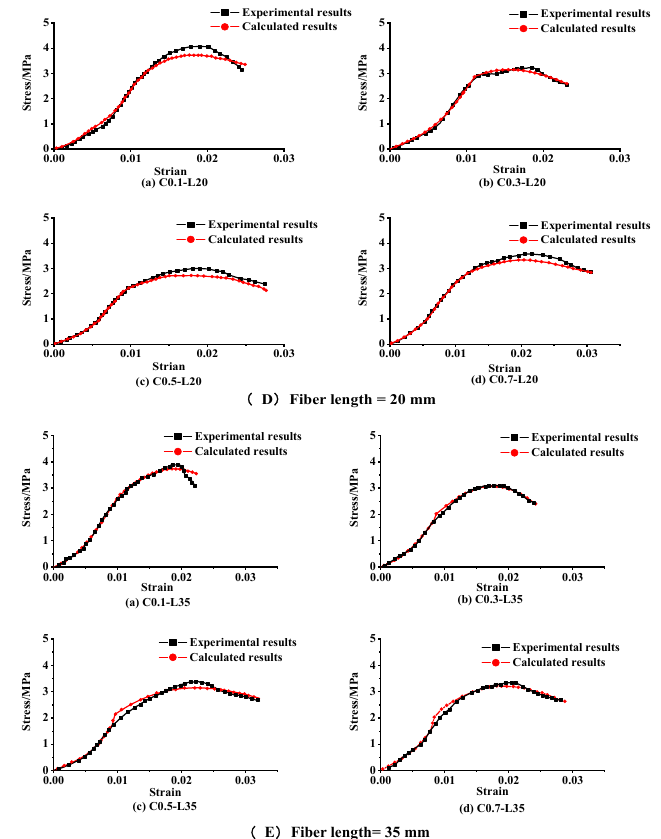
Figure 13. Comparison of the calculation results of the proposed constitutive models with the experimental results of stress–strain curves of the fiber-reinforced cemented soil.